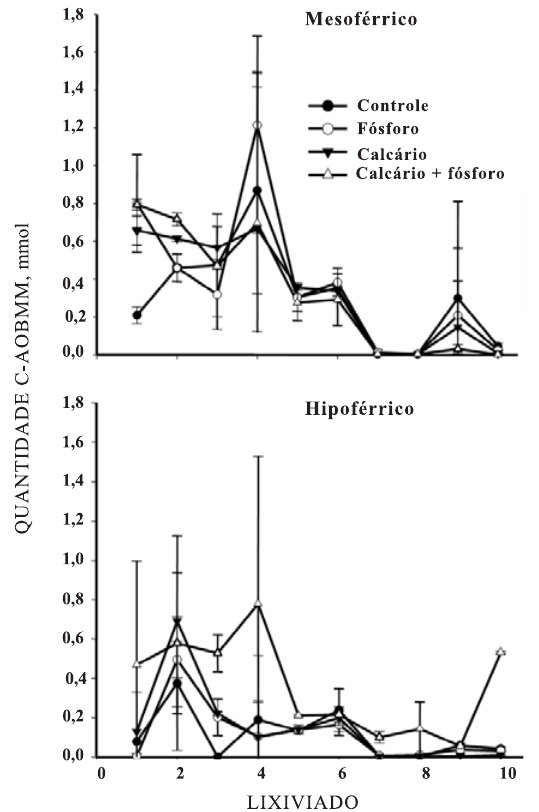
Figura 2. Distribuição das quantidades de C na forma de ácidos orgânicos de baixa massa molar (C- AOBMM) em lixiviados Latossolos Vermelhos (mesoférrico – LV1 e hipoférrico – LV2) tratados com calcário e, ou,